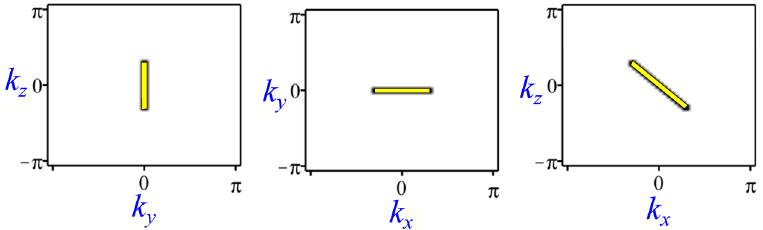
Figure 9. Penetration depth for the Hopf Hamiltonian. ( a ) For 1, 3 p , q and ( b ) For the best fit suggests ν x [ ] = [ ] corresponding critical exponents given in Fig. 8.